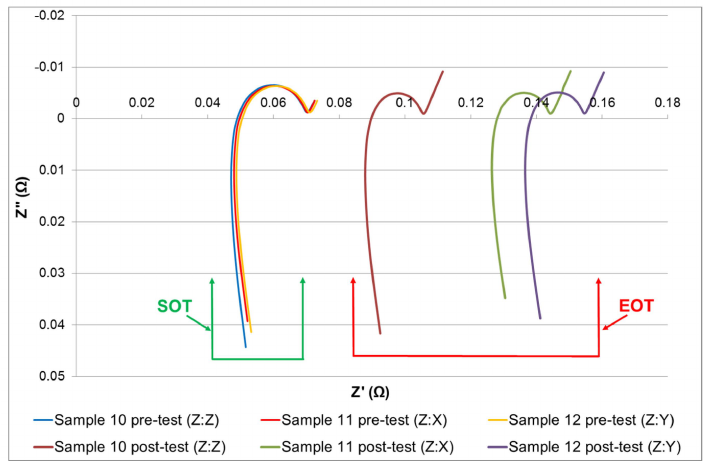
Figure 11. Typical electrochemical impedance spectroscopy (EIS) pre and post test